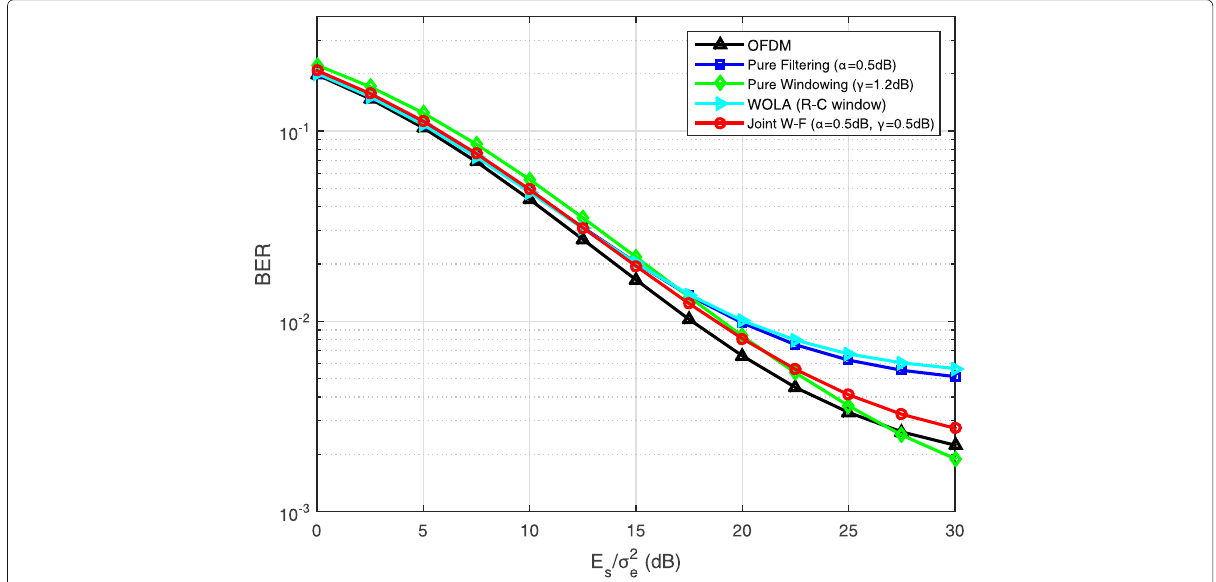
Fig. 15 BER performance with ETU channel model (16QAM, L =